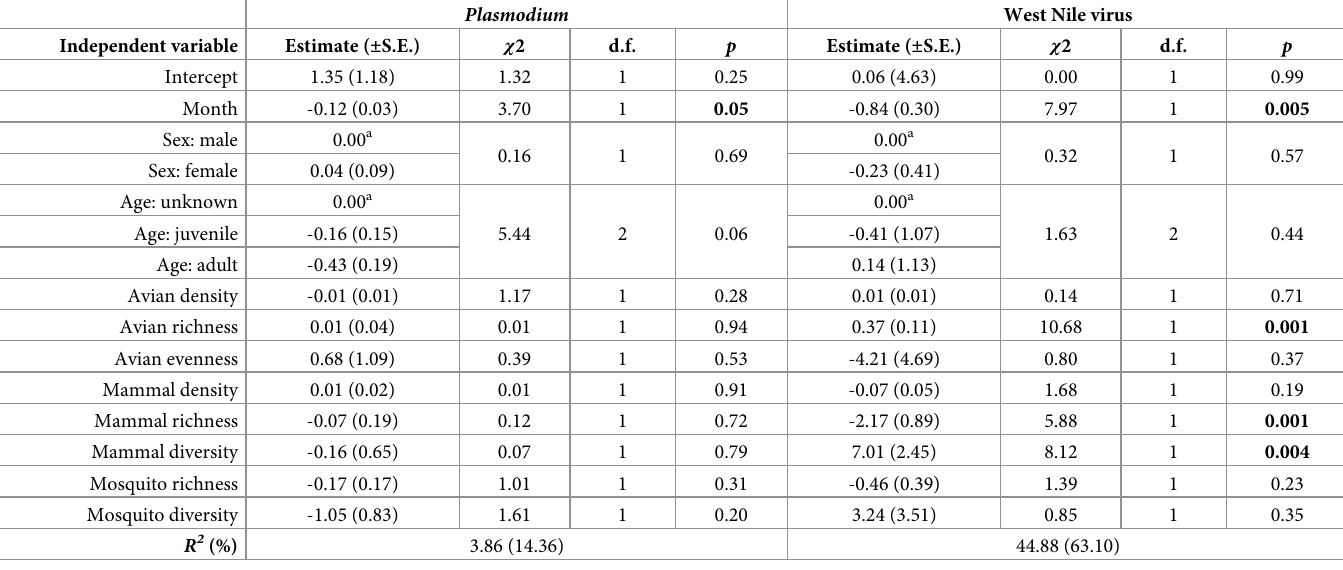
When mosquito-related variables were added to Plasmodium and WNV models (the two studied mosquito-borne pathogens), all the previous significant associations between pathogen infections and variables reflecting vertebrate communities remained the same (Table 2). No significant association was found between infection by Plasmodium or WNV and either mos- quito species richness or diversity (Table 2). Table 2. Results of the GLMMs analysing the relationship between the prevalence of the two studied mosquito-borne pathogens: avian malaria Plasmodium (N = 2,588) and seroprevalence of WNV (N = 2,544) and the individual characteristics of the house sparrows (age, sex, and month of capture), avian and mammal species density, richness (measured from a rarefaction curve) and diversity (calculated as evenness index), vector richness (estimated from a rarefaction curve) and diversity (calculated as evenness index). Significant relationships ( p � 0.05) are highlighted in bold. Conditional and marginal (in brackets) R 2 variance are shown. Plasmodium West Nile virus Independent variable Estimate ( ± S.E.) χ 2